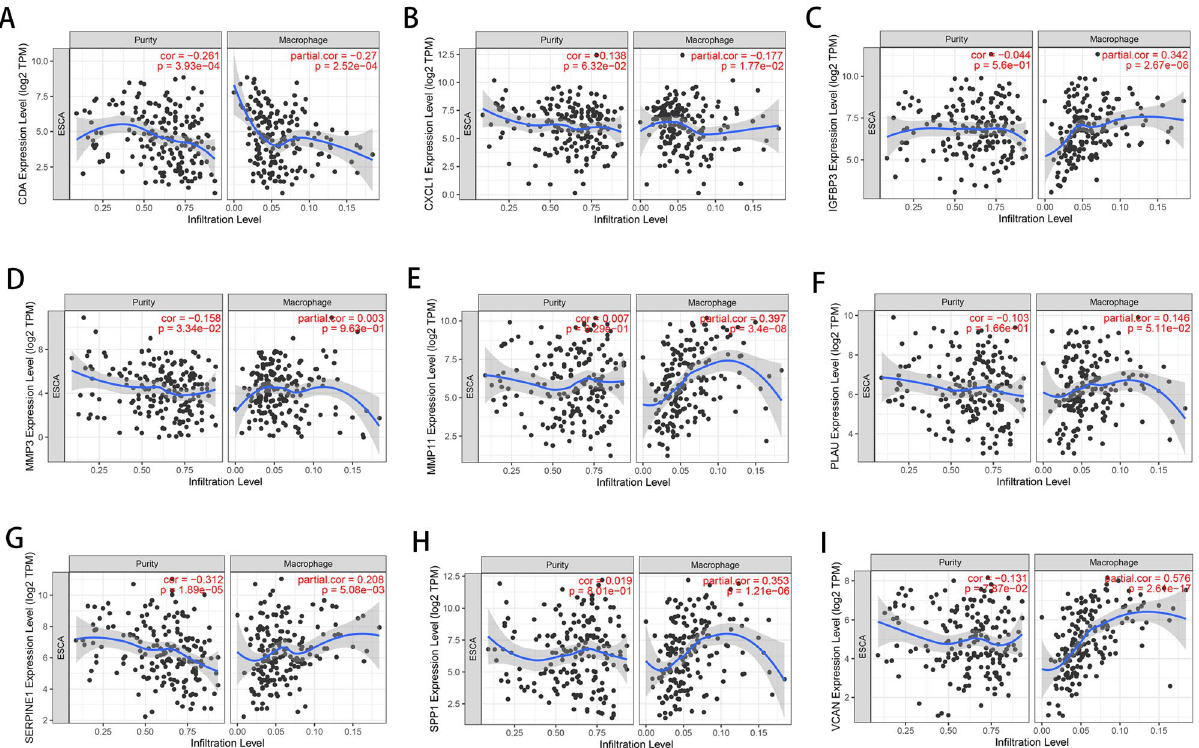
Figure 7. Correlations between hub genes and immune infiltration levels validated with the TIMER database. Correlation of the ( A ) CDA, ( B ) CXCL1, ( C ) IGFBP3, ( D ) MMP3, ( E ) MMP11, ( F ) PLAU, ( G ) SERPINE1, ( H ) SPP1 and ( I ) VCAN expression levels with the macrophage infiltration level, as well as the purity of tumor cells. TIMER, Tumor Immune Estimation Resource.